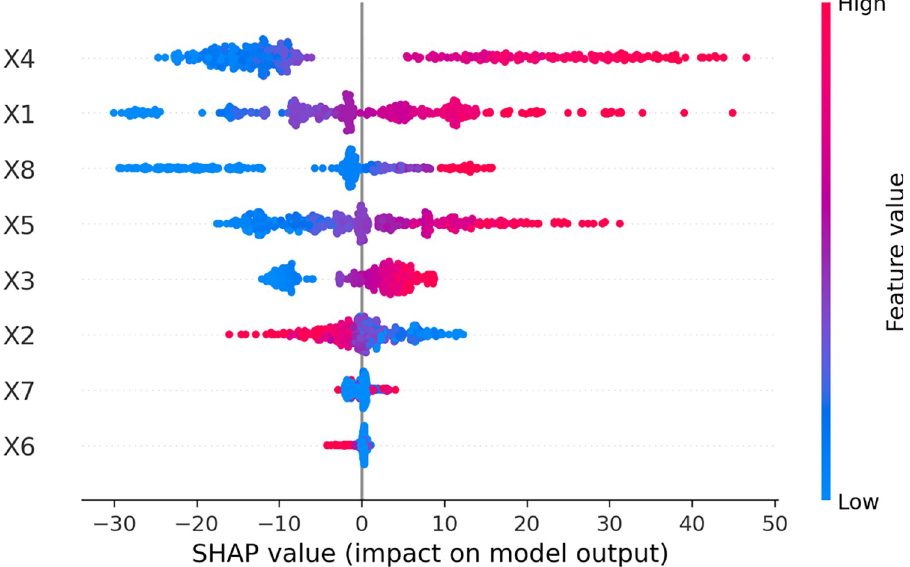
Fig 11. Feature importance of 8 variables used in this